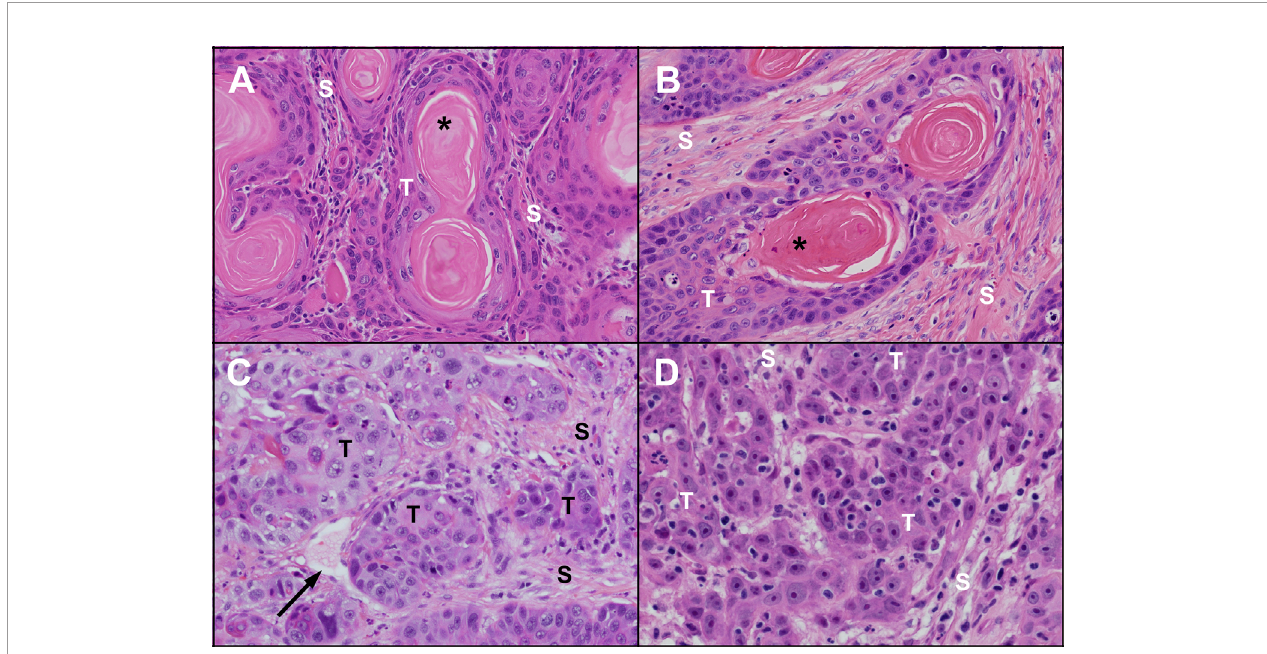
FIGURE 1 | Microscopic appearance of untreated human and feline OSCC. Human (A) and feline (B) OSCC tumours (T) with clusters of well differentiated malignant squamous epithelial cells showing progression from peripheral basal-like cells through strati fi ed squamous epithelium with keratinization forming a central ‘ keratin pearl ’ (*). Islands of OSCC cells are surrounded by supporting stroma (S) composed of fi brous connective tissue ( fi broblasts and collagen). Less differentiated human (C) and feline (D) OSCC are composed of irregular islands and trabeculae of tumour cells (T) lacking orderly arrangement and keratin pearls. A thin walled vessel (vein or lymphatic) is indicated by the black arrow. (haematoxylin and eosin stain, 40X